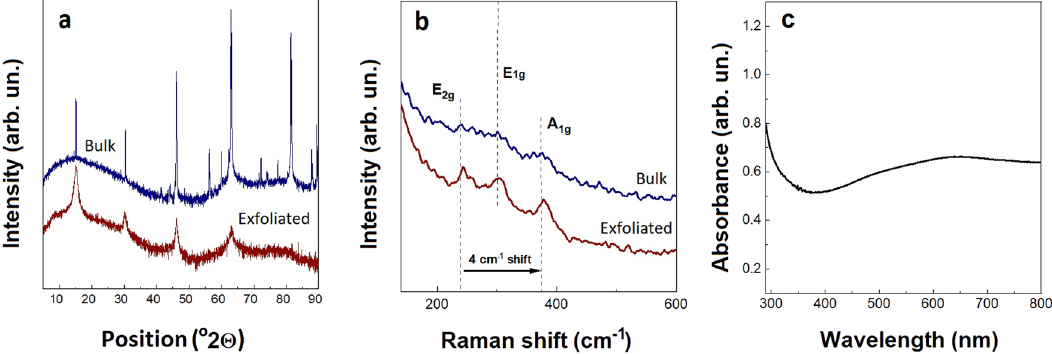
Fig. 5 Structural and optical characteristics of TaS 2 . a XRD diffractogram of bulk TaS 2 and electrochemically exfoliated nanosheets; b Raman spectra of bulk and electrochemically exfoliated TaS 2 ; c UV-VIS absorbance spectra of the exfoliated TaS 2 in the DMF. ascertaining the high crystallinity of the sample. Similar peaks were observed in the exfoliated material ’ s XRD pattern, albeit broadened and with lower intensity caused by the disruption of initial crystallinity due to the exfoliation procedure. The broad- ening of the XRD peaks indicates a decrease in crystal size and lattice strain increase. Figure 5b shows the Raman spectra of bulk and as-exfoliated TaS 2 samples. Three main Raman features depicted at 239, 301, and 373 cm − 1 from the bulk crystal were assigned to the E 2g , E 1g , and A 1g modes, respectively 28,41 . More prominent peaks of the same modes and their 4 cm − 1 redshifts were observed for the exfoliated nanosheets. The shift is attributed to the decrease of the interlayer van der Waals forces and the material ’ s thickness reduction. UV-VIS absorption spec-